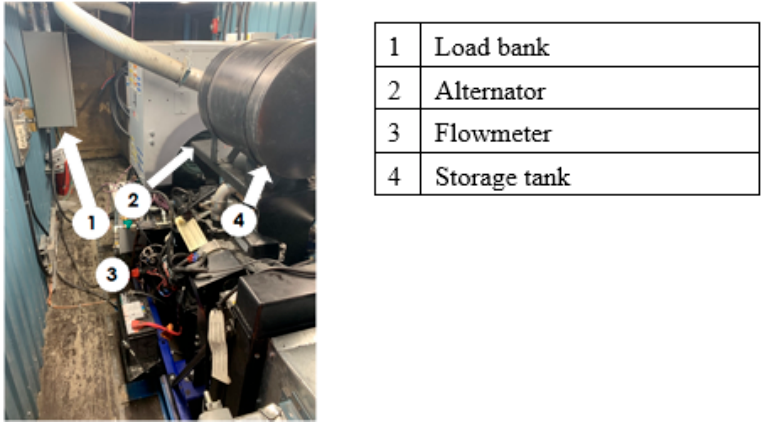
Figure 3. Illustration of the test bench inside the insulated container installed in northern Quebec.